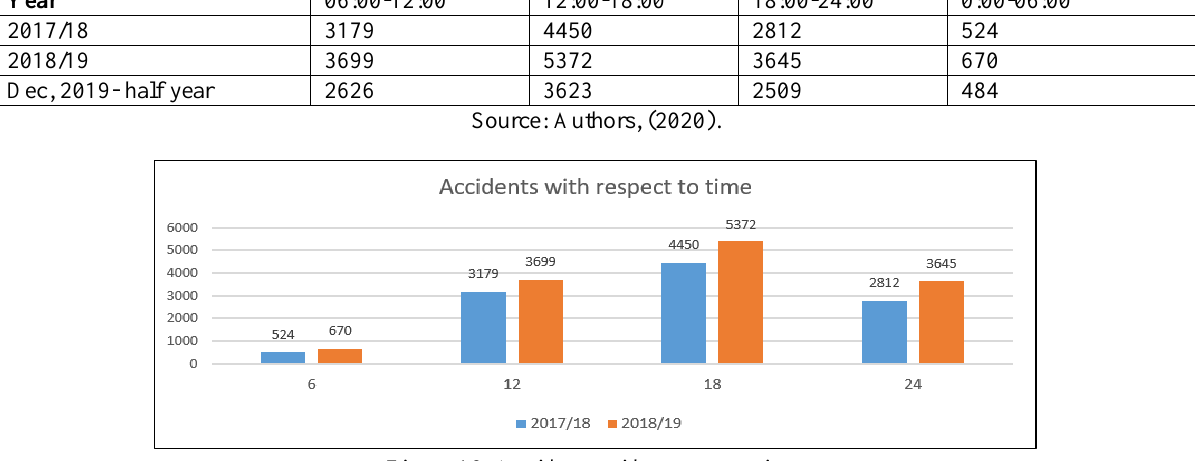
Figure 16: Accidents with respect to time.